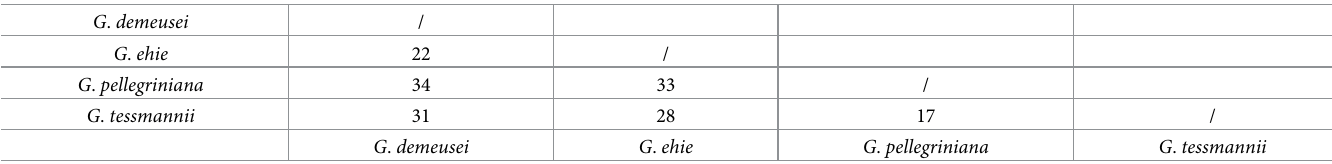
Table 9. SNP variation in the ITS (ITS1 & ITS2) region among Guibourtia species. G .